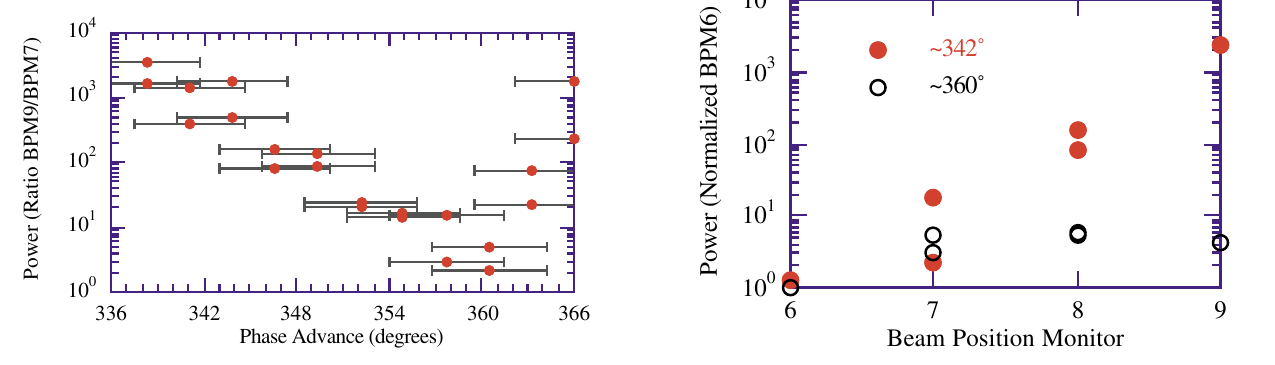
FIG. 12. (Color) Spectral peak power as a function of phase advance.